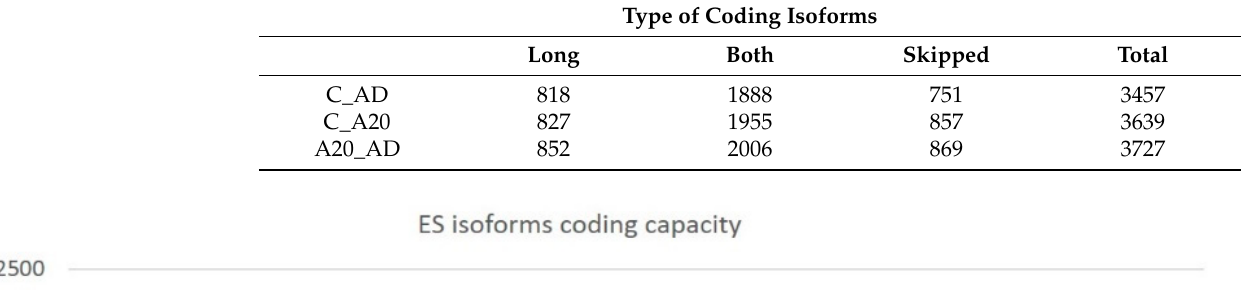
Table 4. Distribution of total consistent coding ES events in pairwise comparisons.